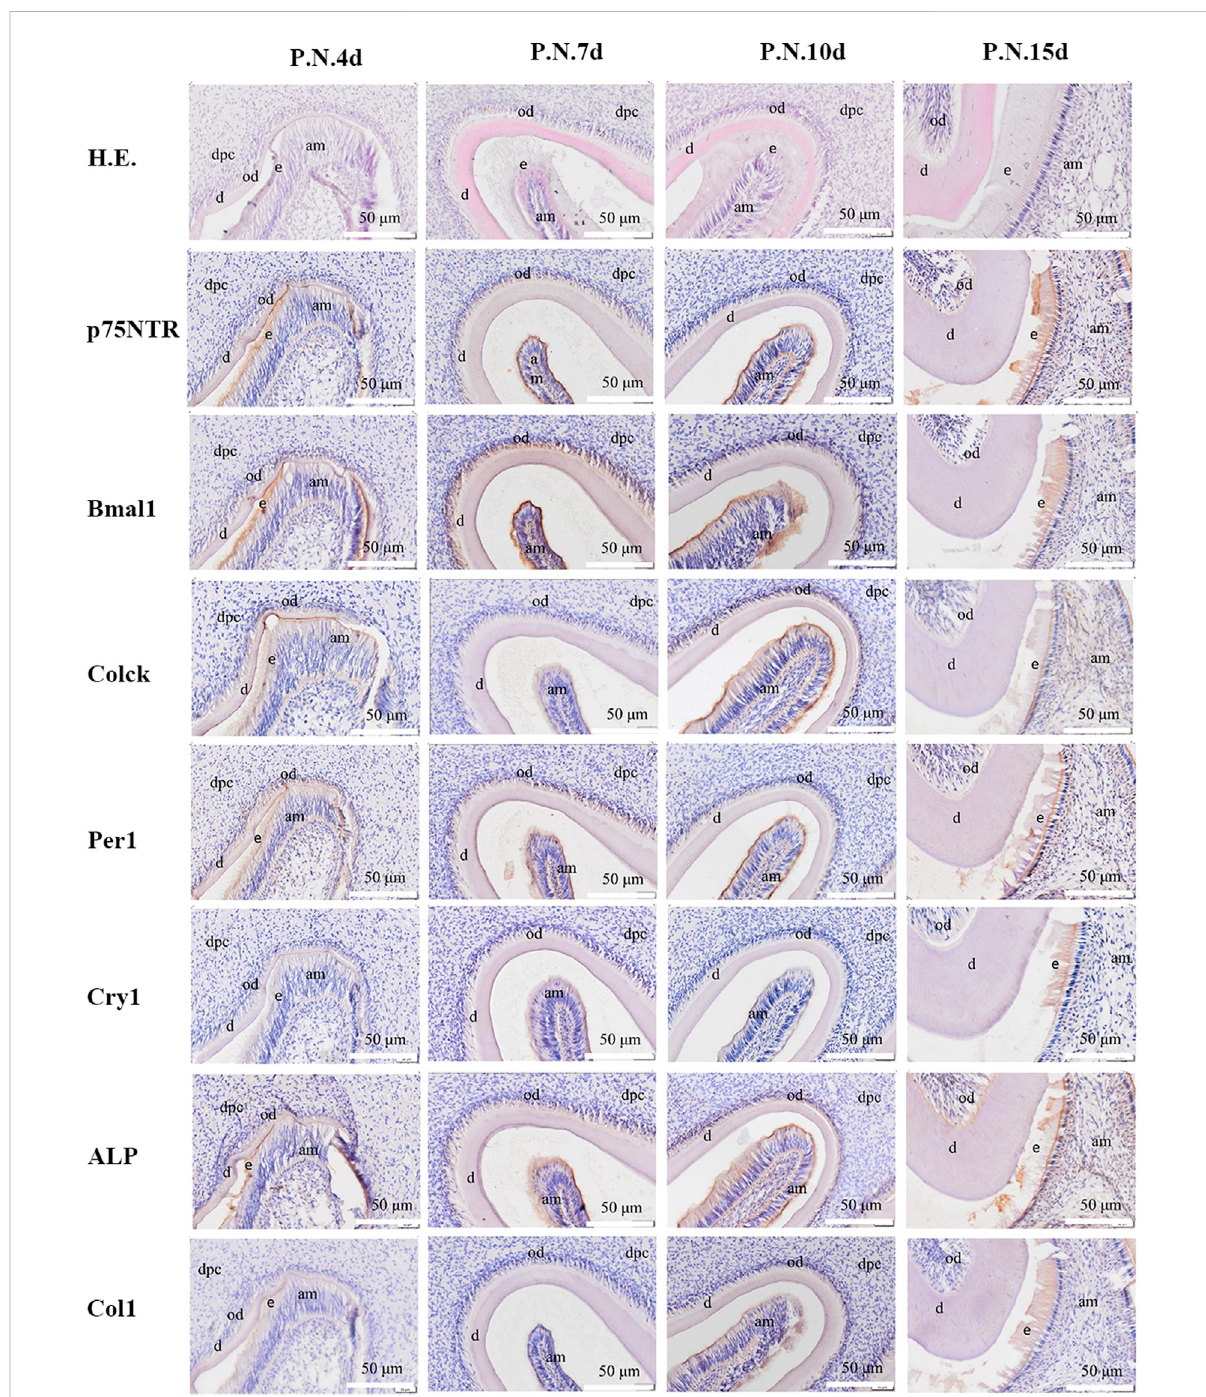
FIGURE 2 The images of H.E. staining and immunohistochemistry staining for post-natal rat dental germs. H.E. staining revealed that the morphogenesis of molar cusps was completed, and hard tissues (enamel and dentine) began to form at PN4 d. The hard tissues gradually thickened at PN7 d. The tooth roots began to shape at PN10 d and PN15 d. The separation continued between the inner enamel epithelium and enamel in all the post-natal species. Immunohistochemistry staining showed that all the factors were detected and distributed in odontoblast and ameloblast layers, and then in dental papilla in the post-natal species. All experiments were repeated three times independently. dpc: dental papilla cells; od: odontoblast; am: ameloblast; e: enamel; d: dentin. The scale bar represents 500 and 50 μ m,